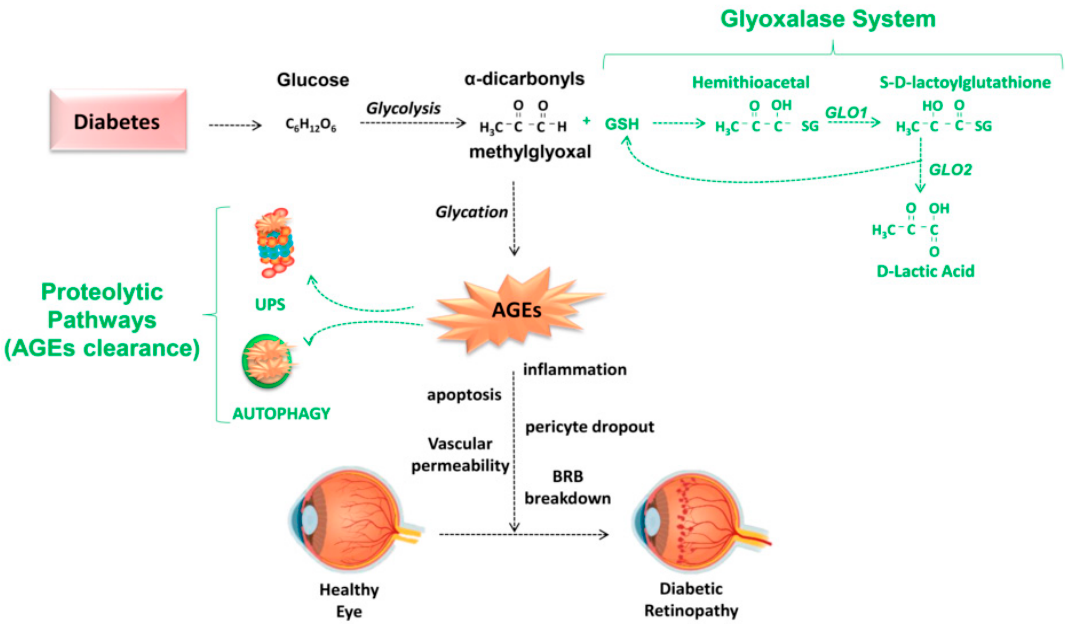
Figure 3. Schematic overview of detoxifying pathways against AGEs-derived damage in diabetic retinopathy (DR). Hyperglycemia-associated diabetes involves the abnormal formation of highly reactive α -dicarbonyls such as methylglyoxal which leads to accelerated AGEs formation. The glyoxalase system is a protective mechanism that slows down the synthesis of AGEs by limiting formation of dicarbonyls. Once formed, AGEs can be cleared by two proteolytic pathways: The ubiquitin-proteasome (UPS) system and autophagy. These protective mechanisms (highlighted in green) decline under diabetic conditions and with age. AGEs are pathologic features in the early stages of DR, impacting the function of neuroglial and vascular cells. AGEs-derived damage results in cellular and tissue dysfunction contributing to the onset of DR. BRB: Blood–retina barrier; GLO1: Glyoxalase 1; GLO2: Glyoxalase 2; GSH: Glutathione.